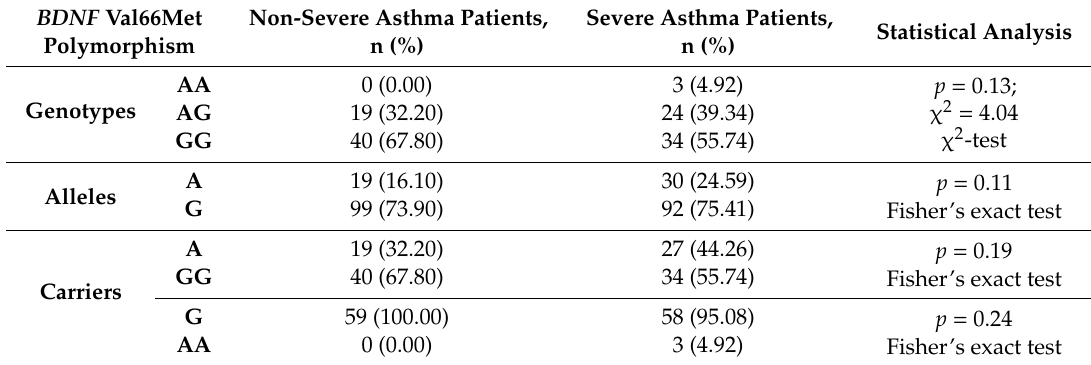
Table 6. Distribution of genotypes, alleles and carriers of BDNF Val66Met polymorphism in non-severe and severe asthma patients.